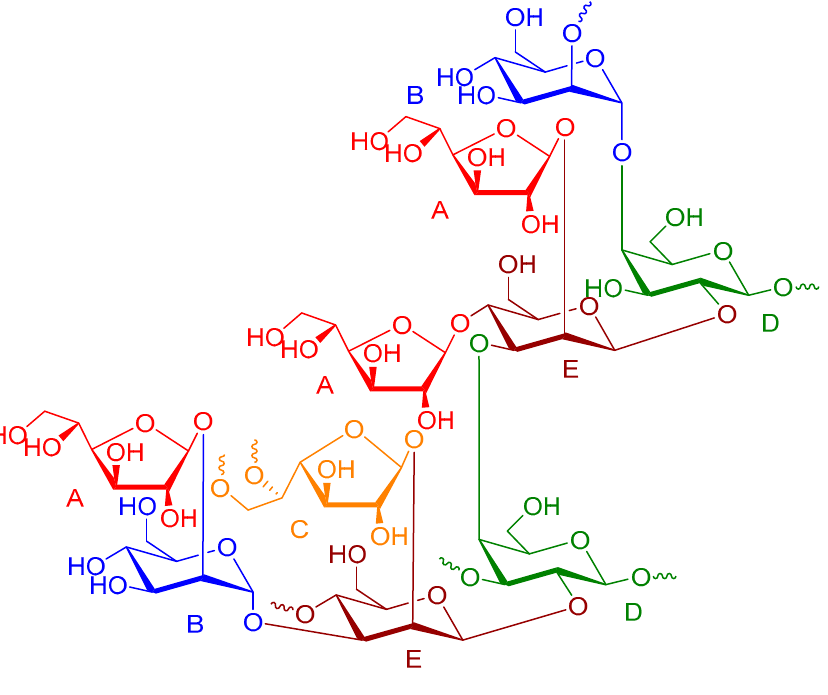
Figure 4. Inferred structure of the IC-FWBP.